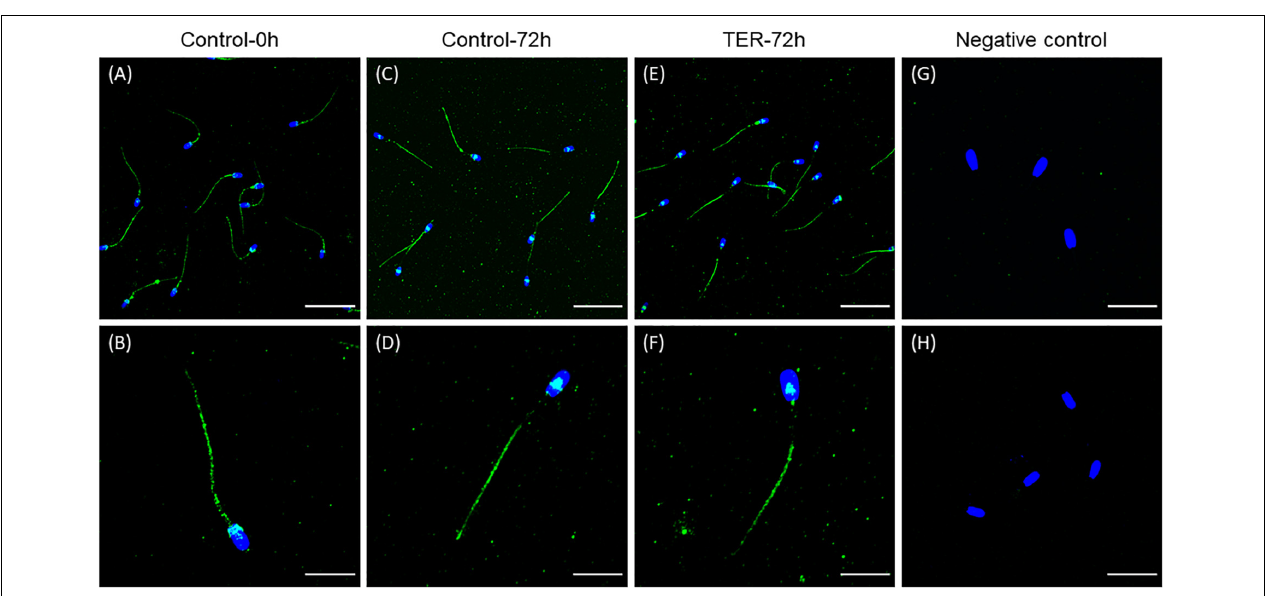
FIGURE 2 | Immunolocalization of GSTP1 in pig sperm. (A,B) Control-0h, semen samples at 0 h of storage. (C,D) Control-72h, vehicle control (dimethyl sulfoxide; DMSO) semen samples at 72 h of storage at 17 ◦ C. (E,F) TER-72h, semen samples treated with 100 µ M ezatiostat (TER) for 72 h of storage at 17 ◦ C. (G,H) Negative control. The nucleus is shown in blue (DAPI), whereas GSTP1 is shown in green. Scale bars: (A,C,E) : 30 µ m; (B,D,F) : 15 µ m; (G) : 20 µ m; (H) : 25 µ m. These results are representative of three independent experiments ( n =